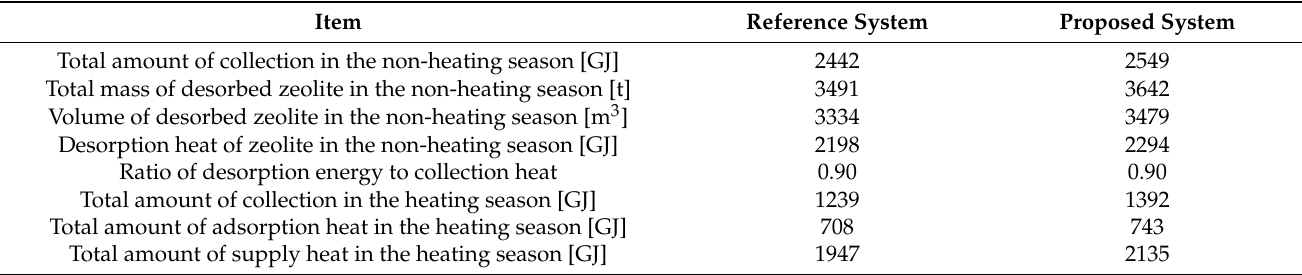
Table 7. Performances of the proposed and reference systems.